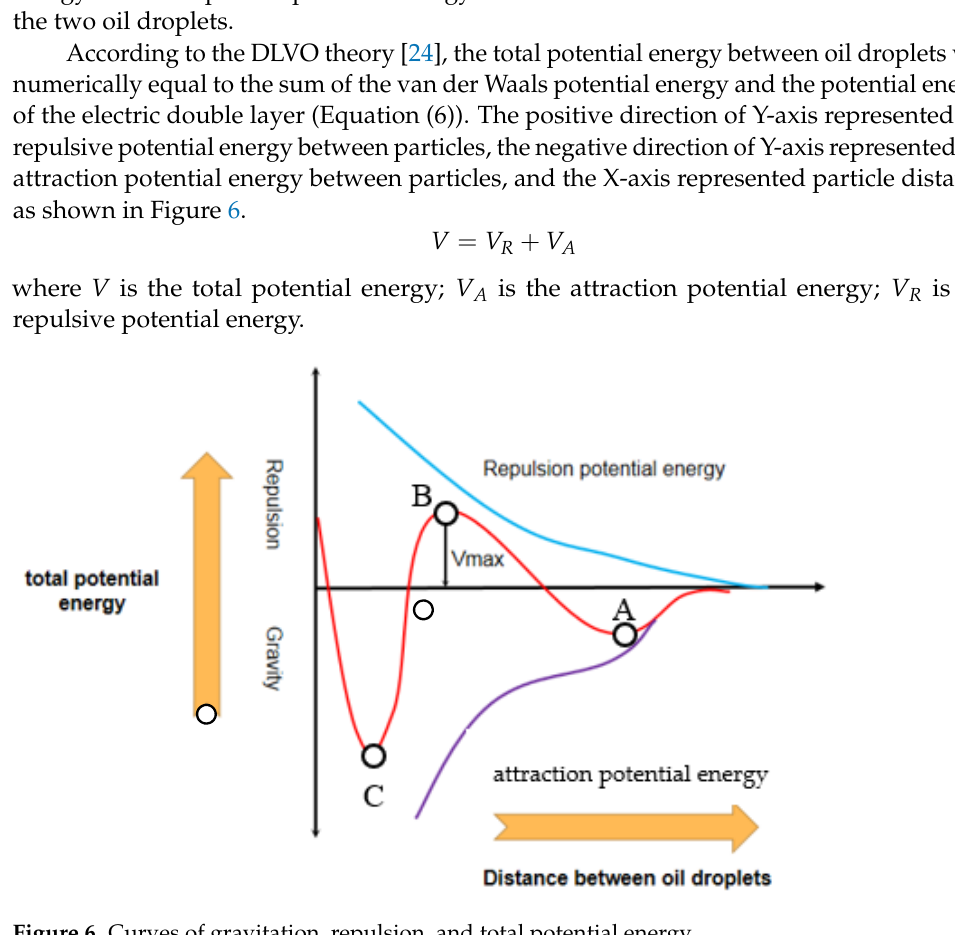
Figure 6. Curves of gravitation, repulsion, and total potential energy.